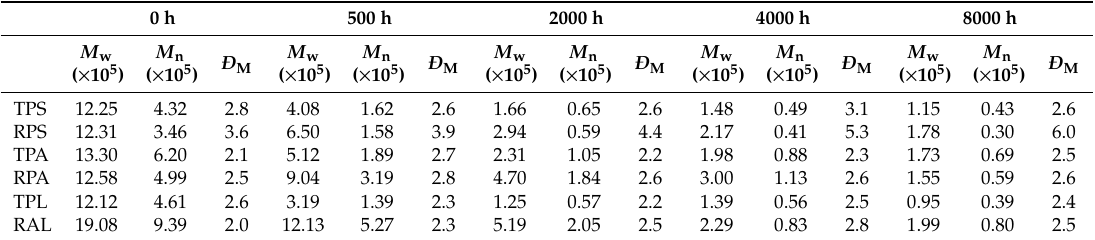
Table 5. Evolution of weight-average molecular weight ( M w ), number-average molecular weight ( M n ), and molecular-weight dispersity ( Ð M ) of the test samples during artificial